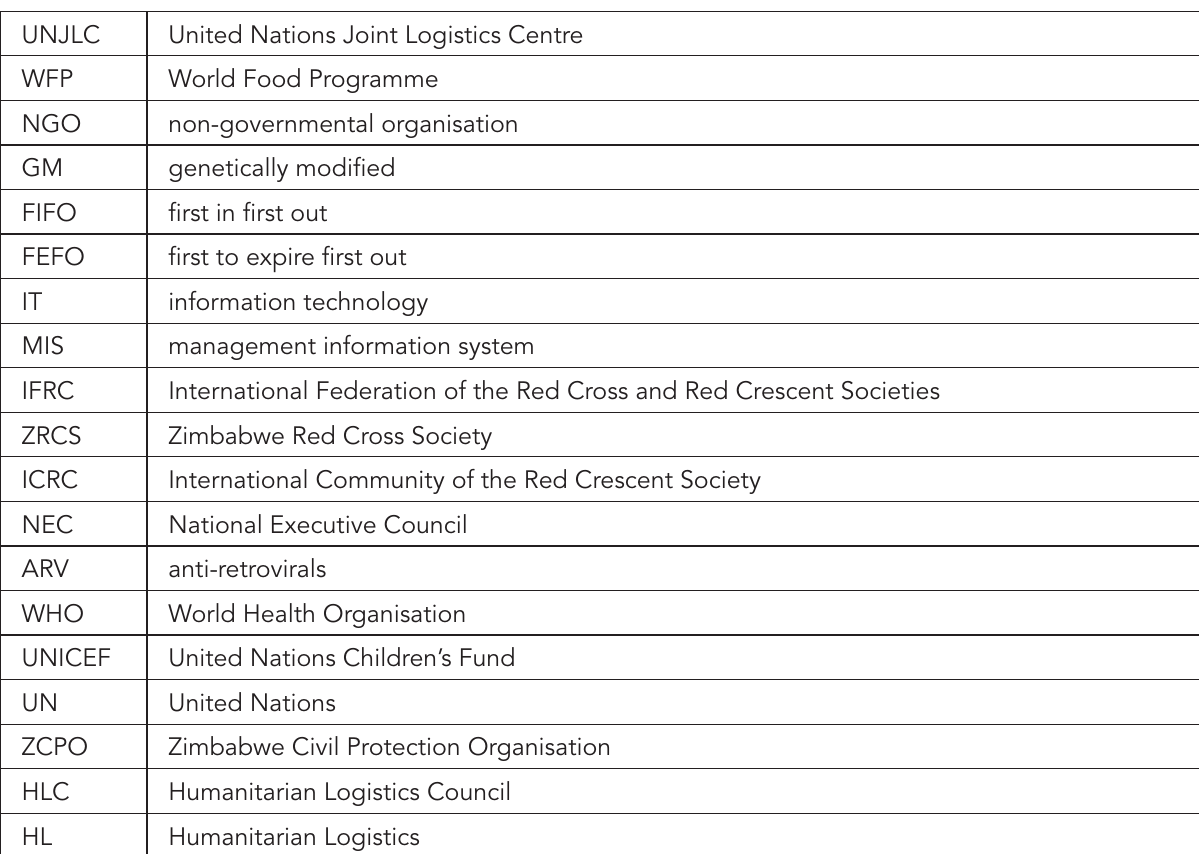
UNJLC United Nations Joint Logistics Centre WFP World Food Programme NGO genetically modified